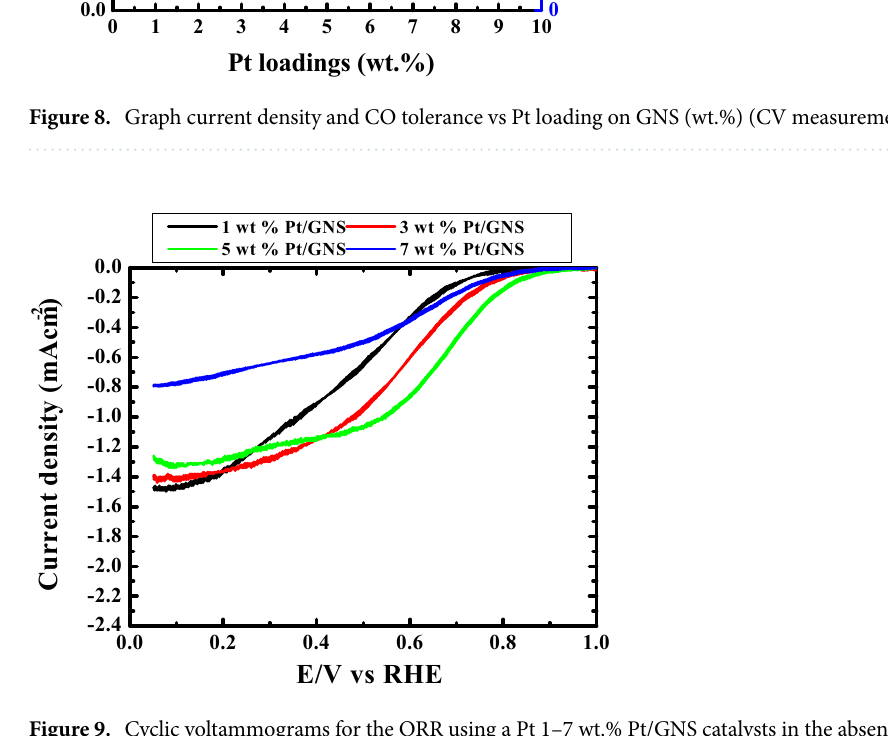
Figure 9. Cyclic voltammograms for the ORR using a Pt 1–7 wt.% Pt/GNS catalysts in the absence of O 2 or under conditions of